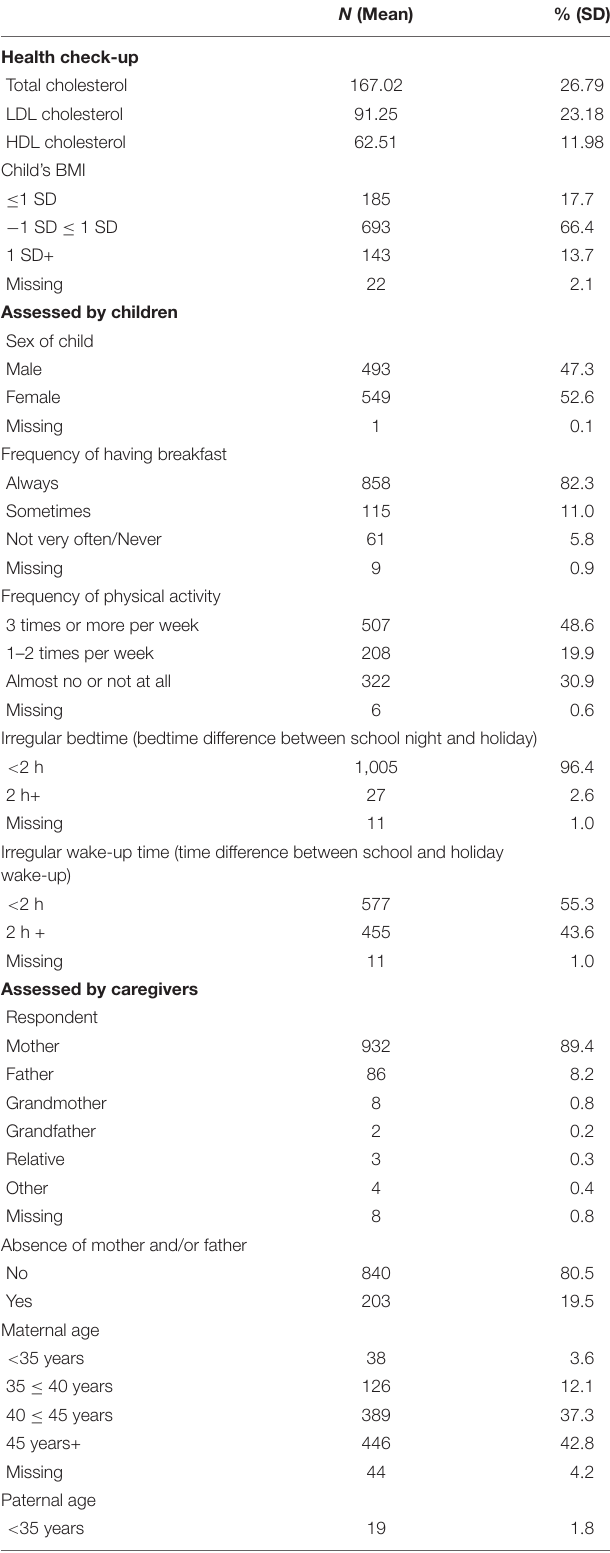
TABLE 1 | Characteristics of sample ( N =